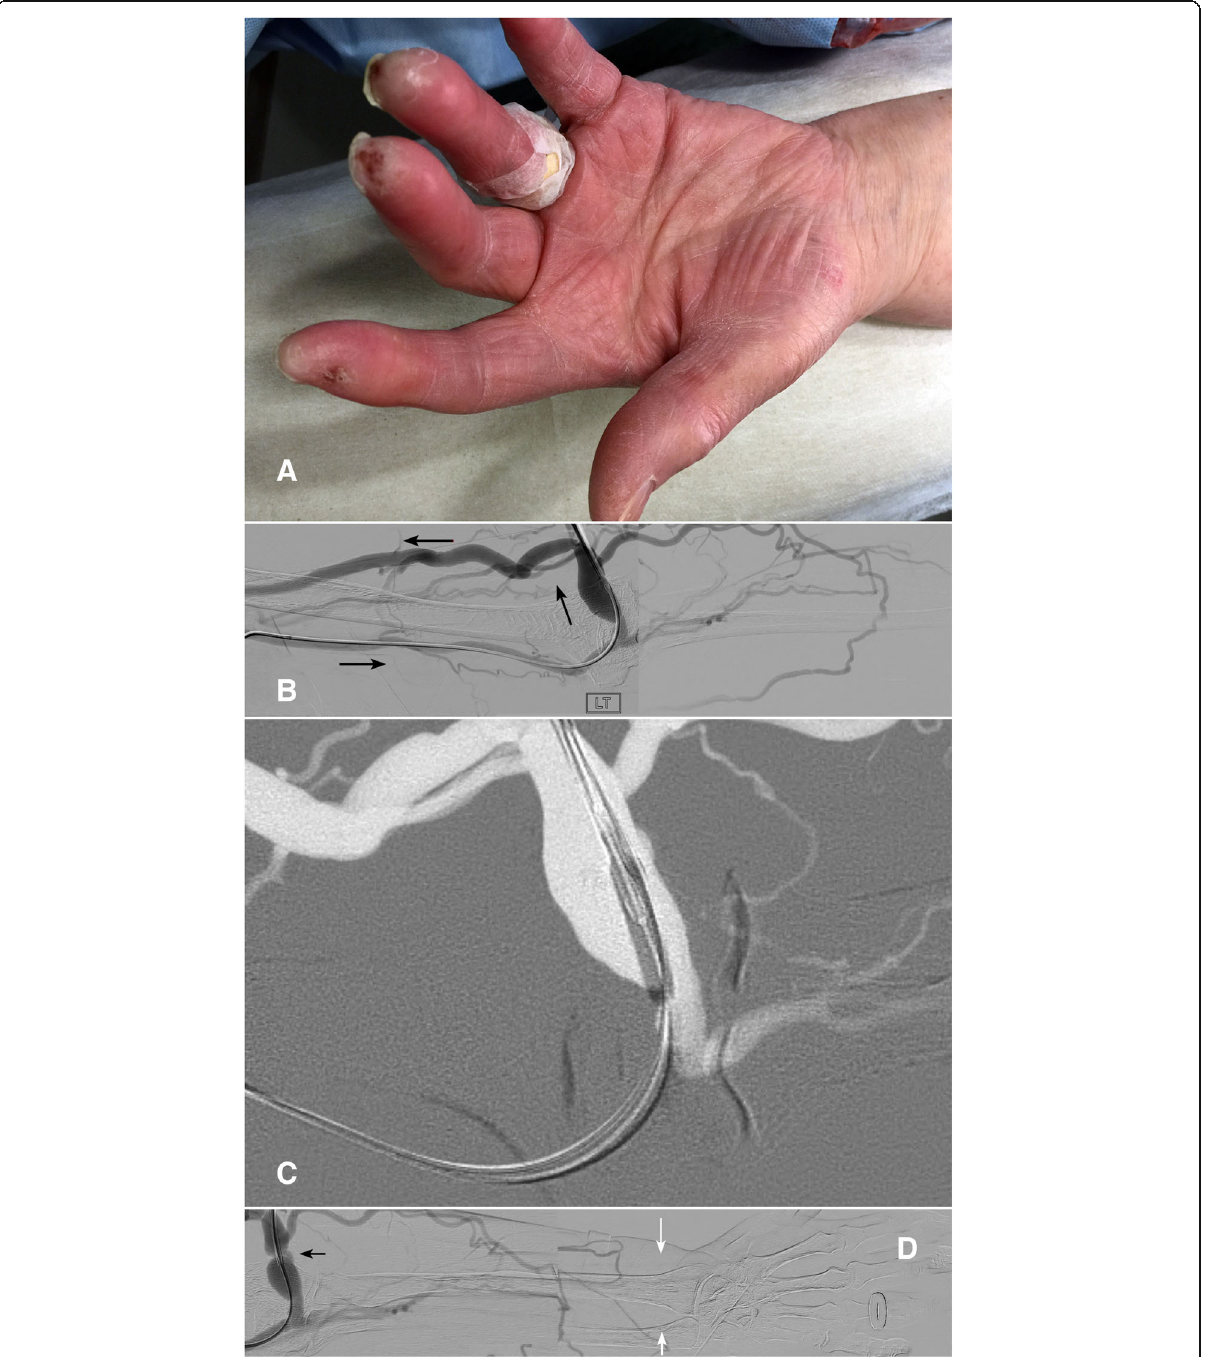
Fig. 2 a Evidence of steal syndrome with associated tissue ulceration at the fingertips. b Diagnostic fistulogram performed through a catheter placed in the inflow brachial artery shows rapid shunting of flow across the AVF into the outflow cephalic vein (arrows indicating flow direction). The radial and ulnar arteries in the forearm are poorly opacified. c Percutaneous AVF banding was performed over a 5×40 mm angioplasty balloon with ( d ) a stenosis created in the outflow vein (black arrow). Perfusion to the forearm was improved but the distal radial and ulnar arteries (white arrows) were occluded secondary to underlying atherosclerosis and the perfusion to the hand did not improved significantly in this